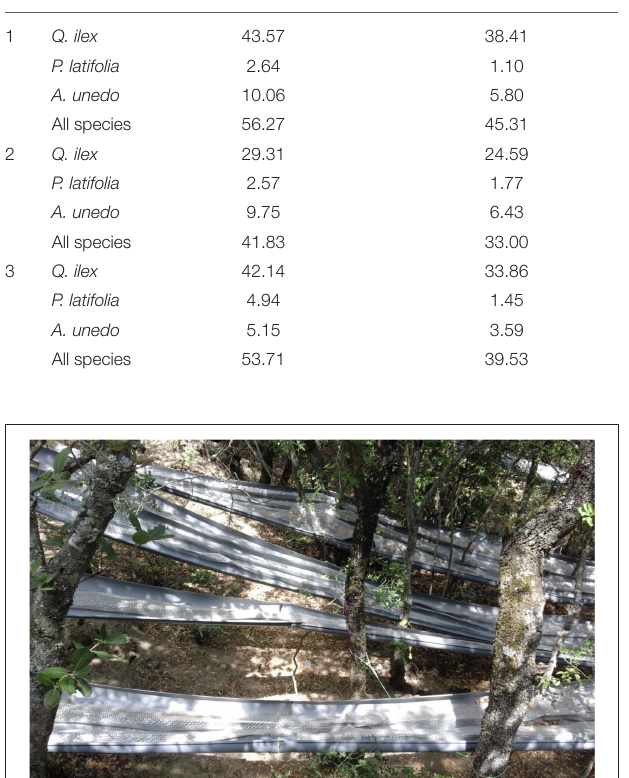
plots were selectively thinned, where ca. 25% of the basal area of each species was removed ( Table 1 ). In drought plots, six plastic strips were installed throughout plot slope, about 1 m above soil surface and down of tree canopies. These plastic strips covered also 2 m above plot margin, and 2 m down of plot margin, to avoid edge effect. Each plastic strip consisted of four rigid ( Figure 2 ), these strips covered about 30% of plot surface and partially intercepted throughfall and removed it downslope the plots. Soil moisture was measured each annual season using a time domain reflectometer (Delta-T Devices, Cambridge, UK) in four randomly selected sites per plot. The reflectometer measured soil moisture in the first 15 cm